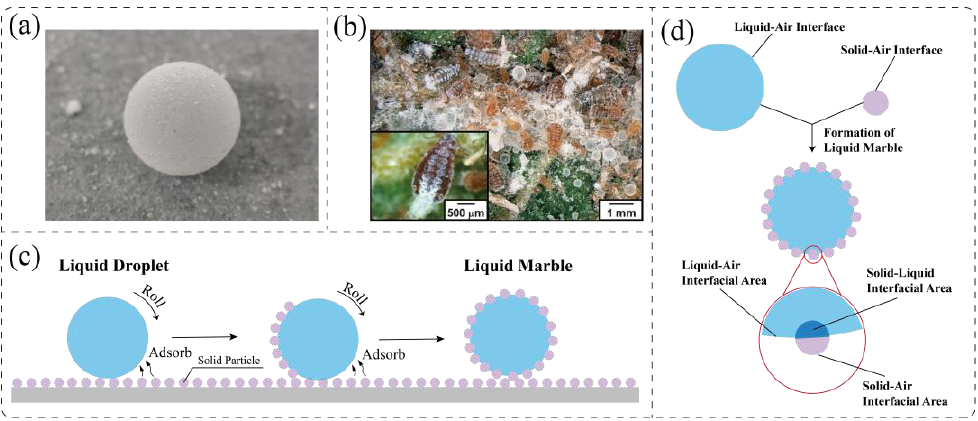
Figure 3. ( a ) An artificial LM from the lab. ( b ) Natural LMs fabricated by aphids [44] (Reproduced with permission from American Chemical Society, 2019). ( c ) Schematic of the formation process of an LM. ( d ) Schematic of interface changes during LM